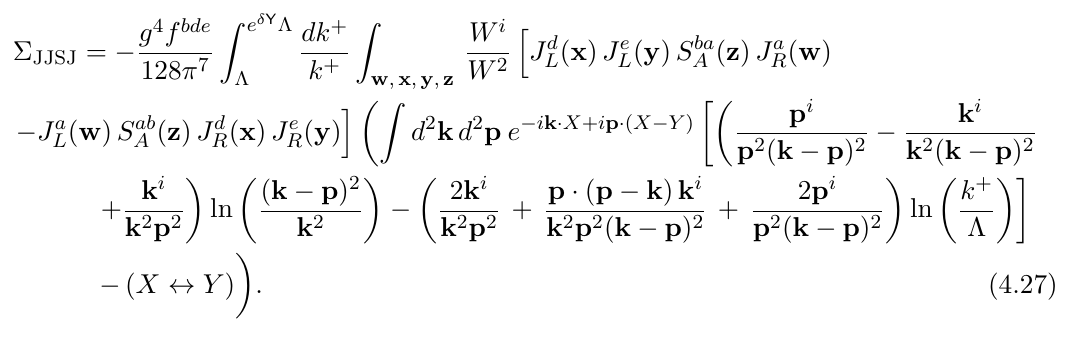
Figure 13 . The diagrams for (cid:6) JSJ . E(cid:11)ective one gluon emission vertex corresponds to j g (cid:26) i . After the (cid:24) integral is evaluated using (C.18) and